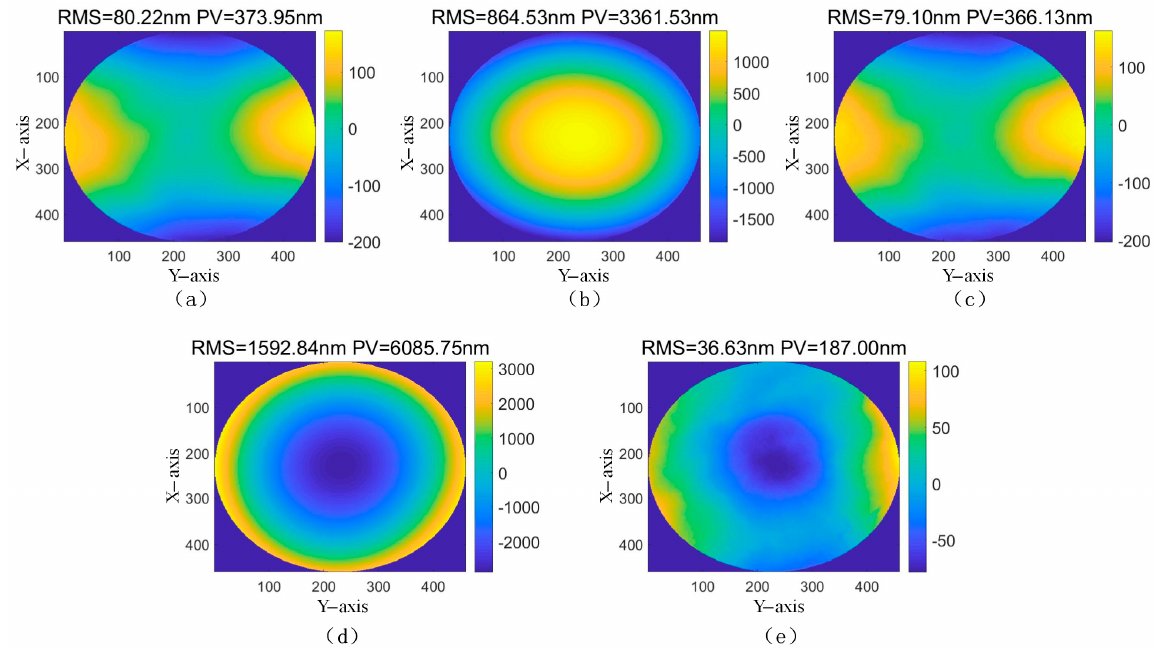
Figure 8. Experiment results of the planar window glass (after removing the first six terms): ( a ) EPCM; ( b ) PM with systematic errors; ( c ) PM after eliminating systematic errors; ( d ) MPMD; ( e ) Interferometer.